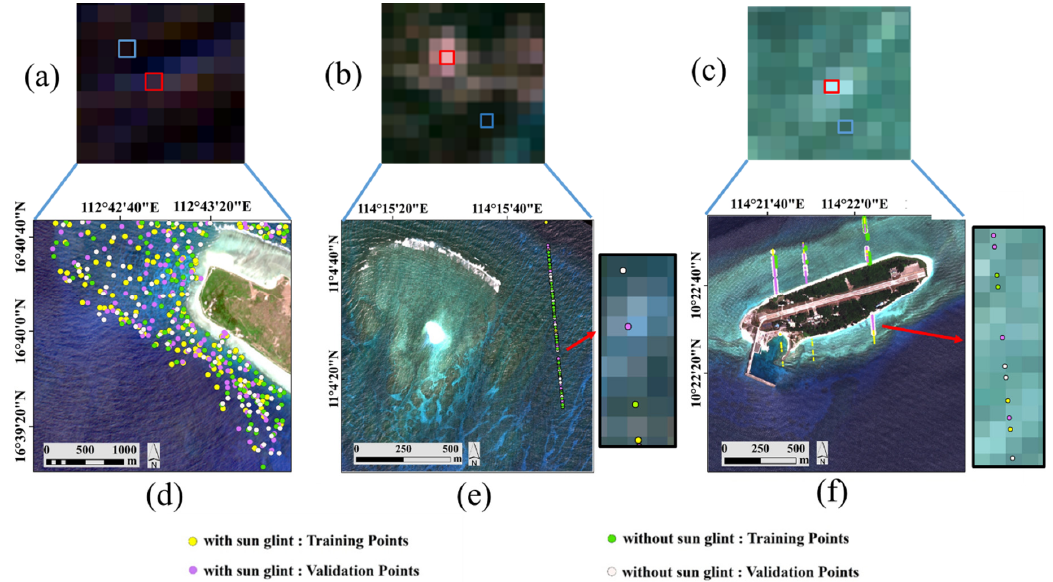
Figure 7. Schematic diagram of sun glint and sun glint ‐ free pixels and spatial distribution of bathy ‐ metric training points and validation points in the three study areas. The red box represents the sun glint pixels, the blue box represents the sun glint ‐ free pixels. ( a ) Schematic diagram of the sun glint and sun glint ‐ free pixels of the Dongdao Island; ( b ) Schematic diagram of the sun glint and sun glint ‐ free pixels of the Tiexian Jiao; ( c ) Schematic diagram of the sun glint and sun glint ‐ free pixels of the Taiping Island; ( d ) Spatial distribution of bathymetric training points and validation points of sun glint and sun glint ‐ free pixels in Dongdao Island; ( e ) Spatial distribution of bathymetric train ‐ ing points and validation points of sun glint and sun glint ‐ free pixels in Tiexian Jiao; ( f ) Spatial distribution of bathymetric training points and validation points of sun glint and sun glint ‐ free pix ‐ els in Taiping Island.